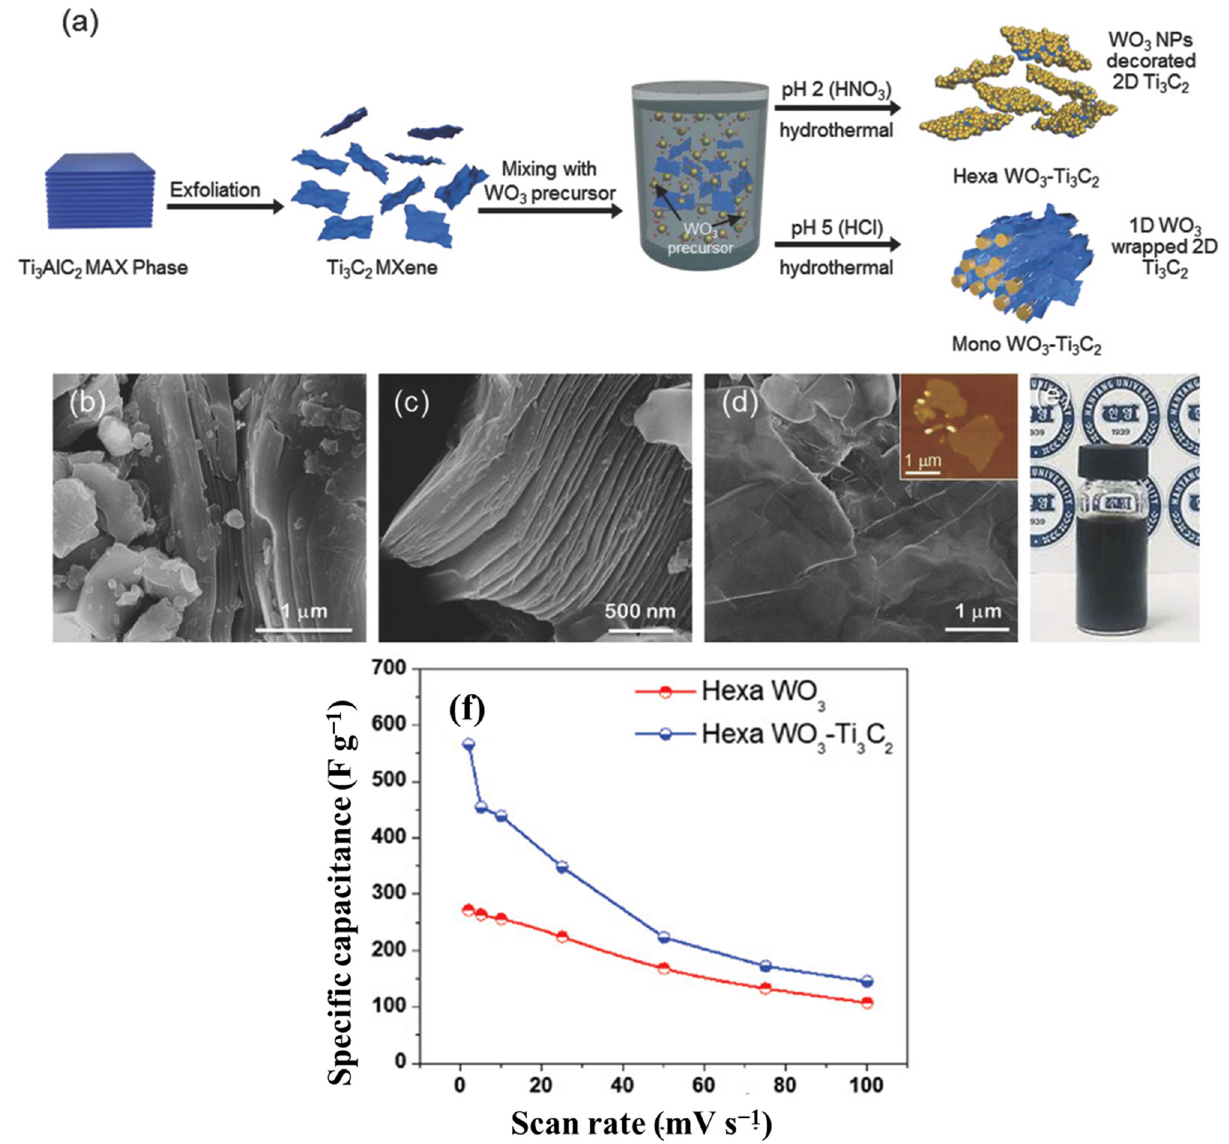
Figure 21. ( a ) An exemplification of fabrication, ( b – e ) FESEM, AFM, and vial images with the ( f ) specific capacitance rate of Hexa-WO 3 electrodes [149].